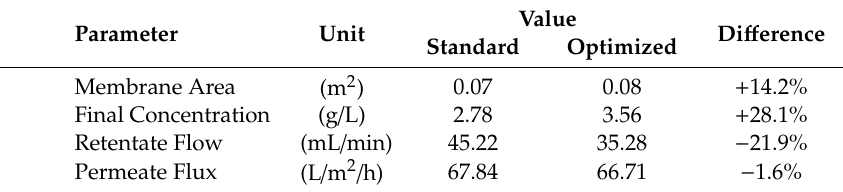
Figure 11. Calculation scenario: Comparison of standard (std.) and optimized (opt.) setup at 1 bar. Table 6. Comparison of standard and optimized setup at 1 bar.